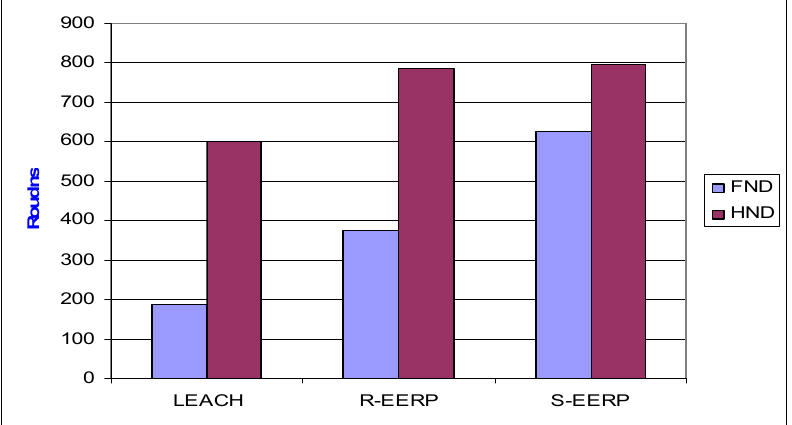
Figure 3. Network lifetime comparison between LEACH and our protocols.